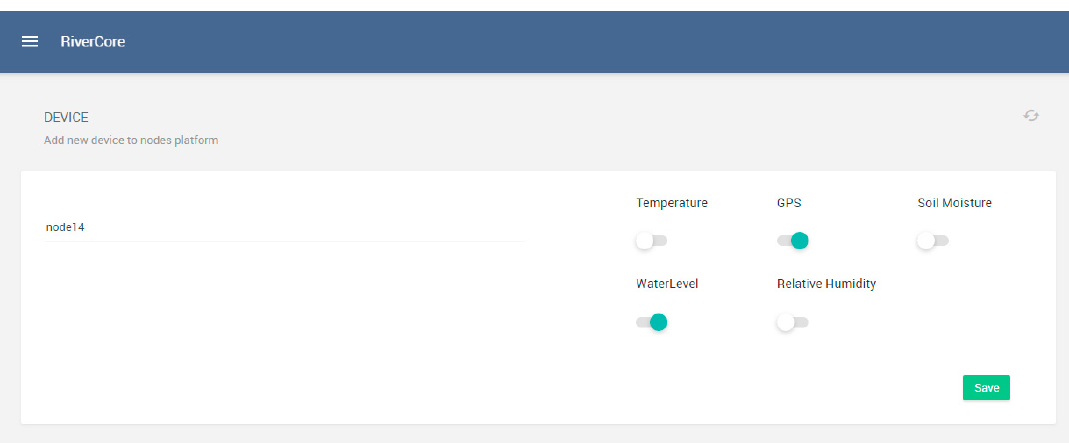
Figure 10. Device registration view.